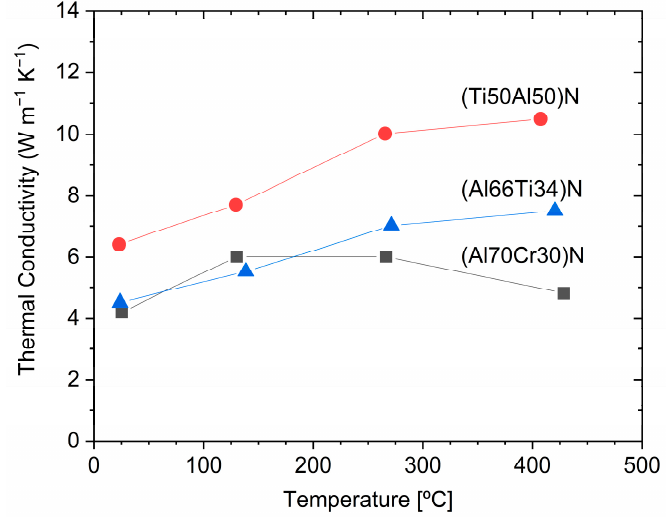
Figure 7. The temperature dependence of thermal conductivity for arc-deposited (Ti 50 Al 50 )N, (Al 66 Ti 34 )N and (Al 70 Cr 30 )N coatings, measured using the picosecond thermal reflection method, redrawn after [67], original © Elsevier.